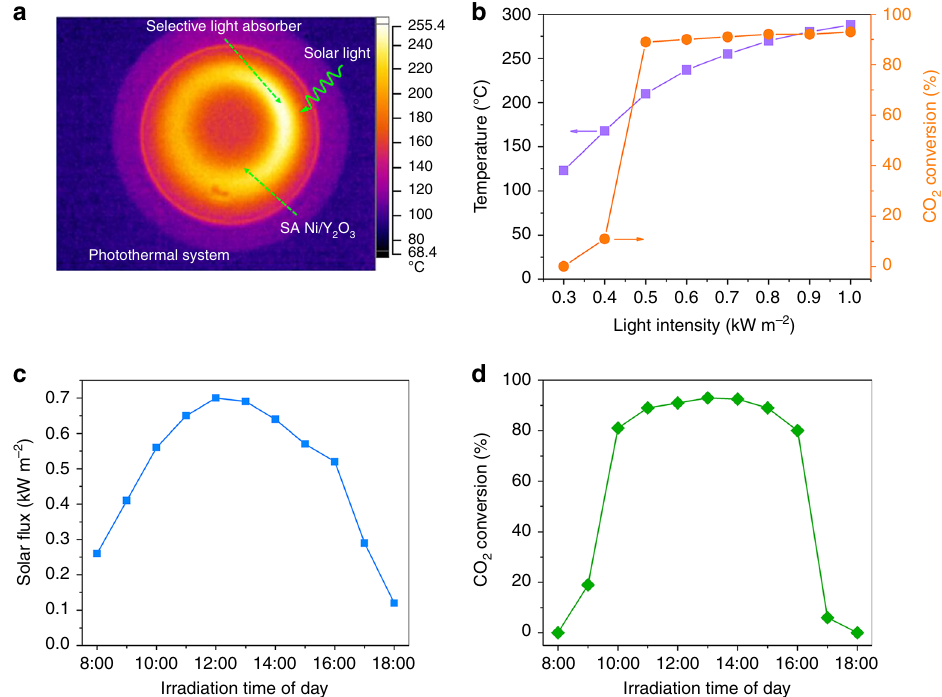
Fig. 5 Photothermal CO 2 methanation performance of the SA Ni/Y 2 O 3 nanosheets with a selective light absorber-assisted photothermal system. a Spatial temperature mapping of the selective light absorber-assisted quartz tube coated with the SA Ni/Y 2 O 3 nanosheets under 1.0 kW m − 2 of simulated solar irradiation obtained by an infrared camera. b The temperature and CO 2 conversion achieved by the SA Ni/Y 2 O 3 nanosheets with the selective